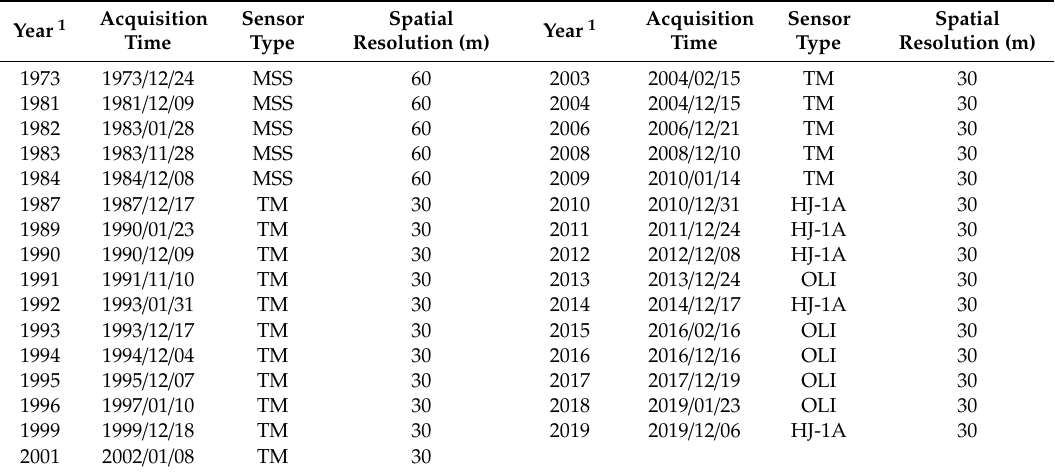
Table 1. List of remote sensing images of Poyang